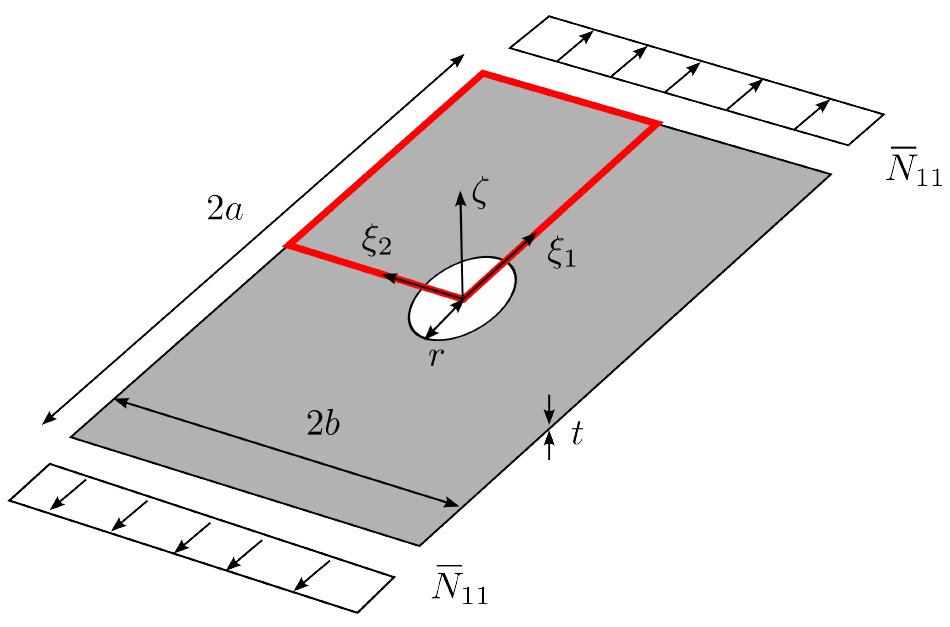
Figure 12. Plate with cutout: